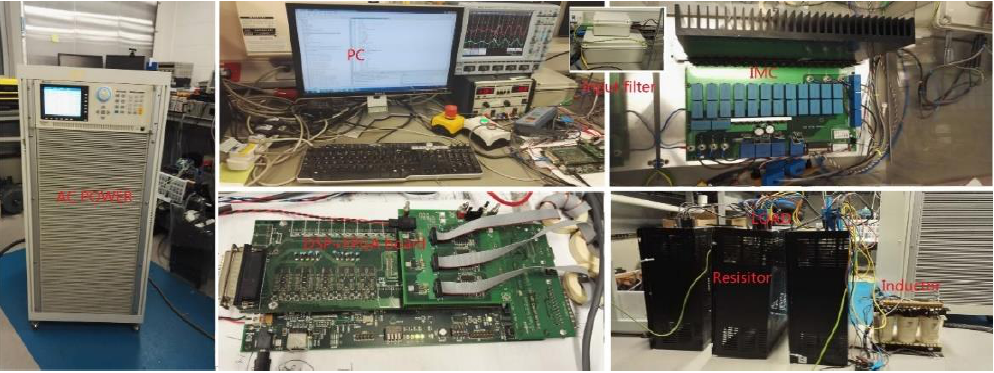
Figure 11. Laboratory TSMC system prototype for evaluation of the proposed control strategy.